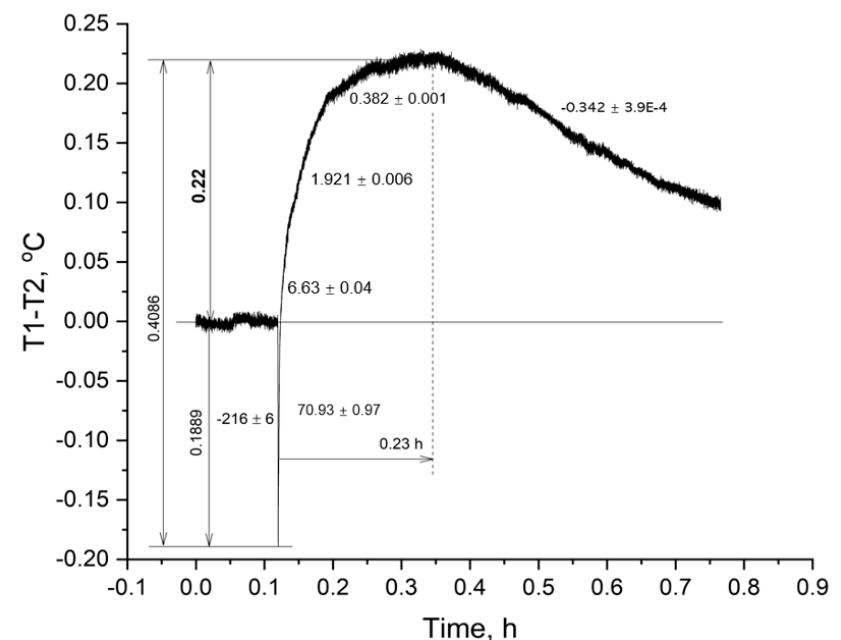
Figure 3. Change in temperature in a suspension of black scorpionfish erythrocytes upon the addition of ATP. Note: the numbers along the curve are the rate of the process, in °C/h. of ATP. Note: the numbers along the curve are the rate of the process, in ◦